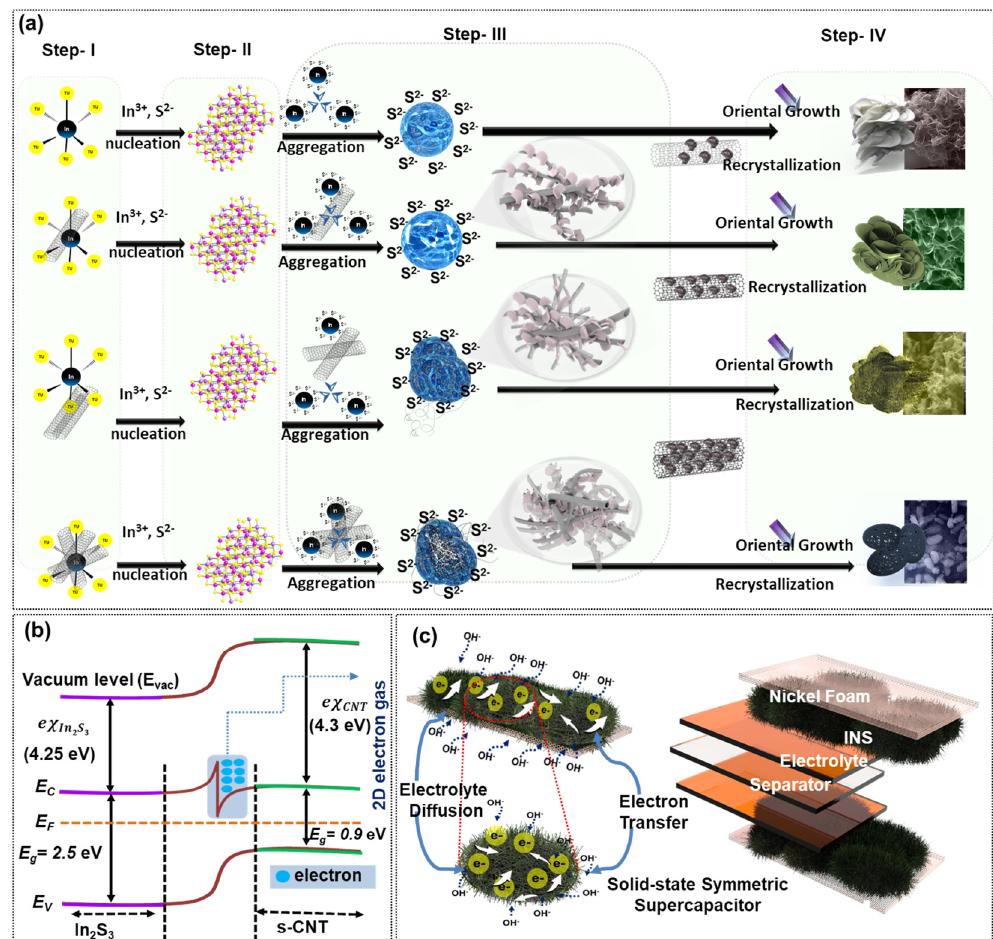
Figure 1. ( a ) Schematic flowchart for synthesis process for InS − SWNT nanostructure formation and heterostructure of In 2 S 3 − SWNTs, ( b ) energy band diagram after contact formation, ( c ) schematic artwork of the fabricated symmetric supercapacitor (SSC) device.